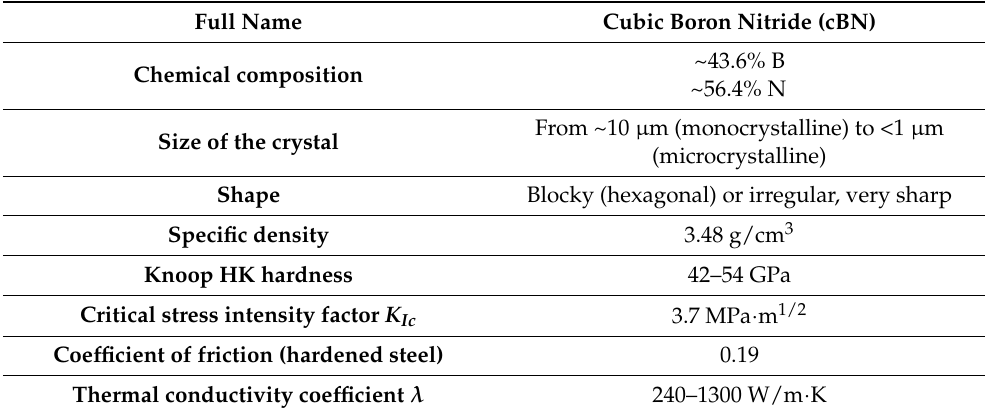
Table 1. Composition and properties of cBN abrasives